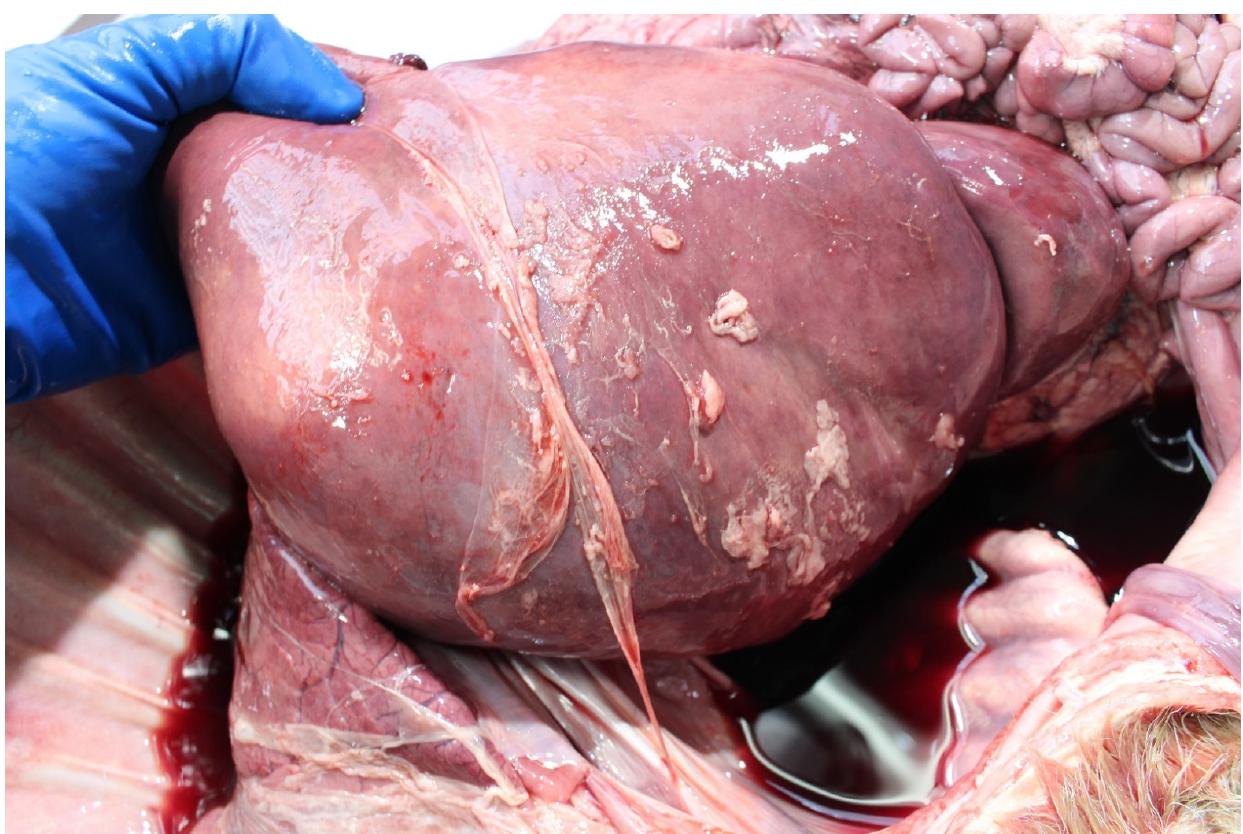
Figure 6. Peri-hepatic fibrinous peritonitis in a perinate which died in utero precalving. Postnatal Infections Infection of the perinate (within two days) after birth from its new environment is normal. However, in calves with failure of passive transfer (FPT), (e.g., zinc sulphate tur- bidity test (ZST) result less than 12.5 units [86]) environmental infection may result in morbidity or PM [69]. Common causes include E.coli septicaemia (colisepticaemia), (e.g., [14]). Though their death may be predisposed by dystocia-induced asphyxia-associated FPT, farmers may be ‘blind’ to such associations or losses hence the role of postnatal in- fection (0–2 days) in causing PM is often underestimated [87]. 2.1.8. Exposure, Infection and Causality In attempting to attribute PM to infection one must differentiate between exposure to infection (foetal antibody detection), the presence of infection (antigen detected in foe- tal/placental tissue) without lesions and infectious causality (antigen/DNA/RNA detected in foetal tissue/abomasal contents with associated lesions or the presence of compelling in- flammatory lesions indicative of infection in the absence of single foetopathogen detection, e.g., pneumonia, encephalitis, pericarditis, omphalophlebitis, peritonitis, septicaemia, hep- atitis, arthritis, nephritis [11] etc, and tests exclude other diagnoses). Therefore, pathogens may be detected in the presence and/or absence of lesions and lesions may be detected in the presence and/or absence of pathogens. This point is illustrated in recent findings from the placentomes of abattoir-sourced pregnant cows in which small numbers of pathogenic bacteria were isolated without the presence of associated lesions [88]. On the contrary, where there is gross or histopathological evidence of infection or response to infection, the combined case evidence may not be compelling that the presumptive foetal infection was